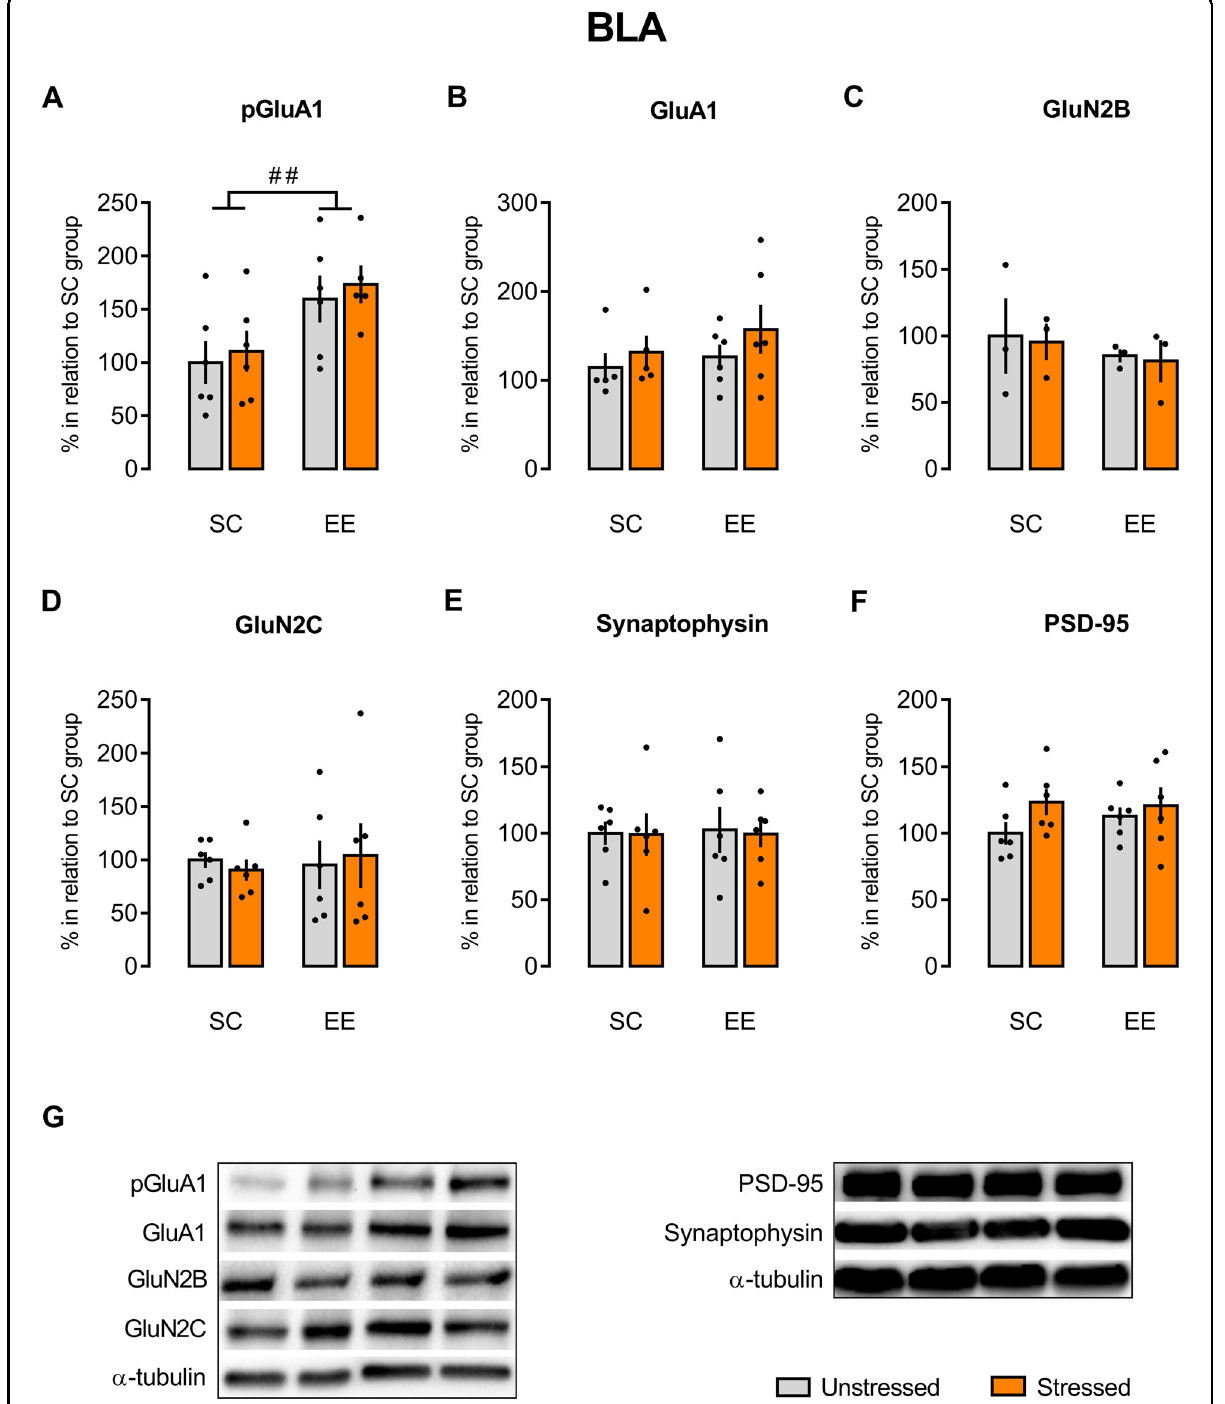
Fig. 4 There is no stress effect on the GluA1 phosphorylation in the BLA, but there is an EE effect. There was an environmental effect on the pGluA1 ( A ) expression in the BLA, but there were no effects of either environment or stress on the expression of GluA1( B ), GluN2B ( C ), GluN2C ( D ), synaptophysin ( E ), and PSD-95 ( F ) in the same brain area. Representative autoradiography of western blot ( G ). Results are represented as mean ± SEM ( n = 5 – 6 animals per group in A and B ; n = 6 for each group in D – F ; n = 3 for each group in C ). Two-way ANOVA followed by Tukey ’ s multiple comparisons test (no differences were detected between the experimental groups). ANOVA signi fi cant main effect is indicated as ## p <